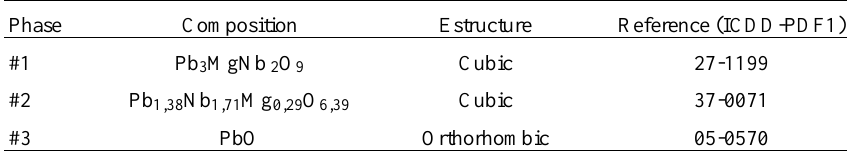
Table 1. Relation of present phases in the PMN powders prepared by both routes.